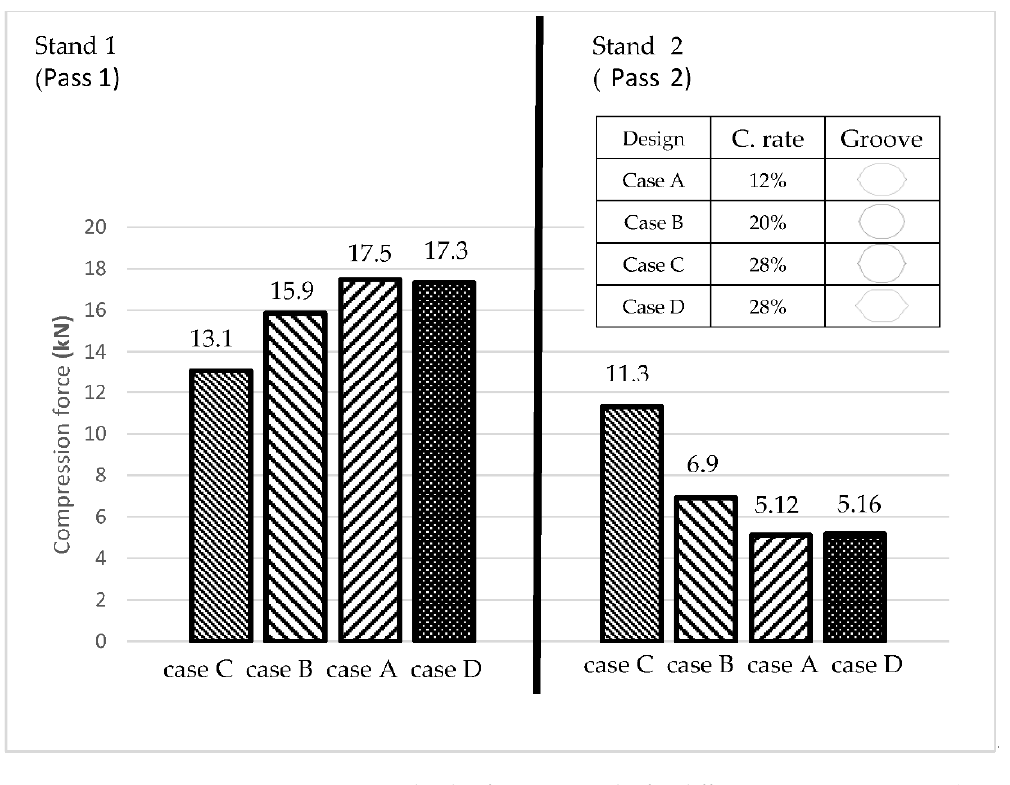
Figure 12. Compression loads of passes 1 and 2 for different compression rates (C. rate) in pass 1.